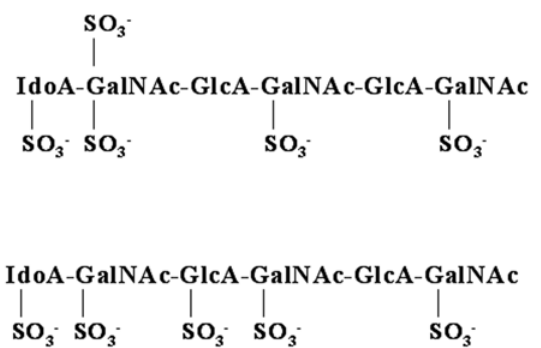
FIGURE 1. Two alternative structure proposals for the pentasulfated CS/DS unsaturated hexasaccharide 4,5- Δ -IdoAGalNAc[GlcAGalNAc] 2 (5S) from human skin fibroblast decorin. The upper structure proposal is the more probable one. Adapted and reprinted with permission from [35].